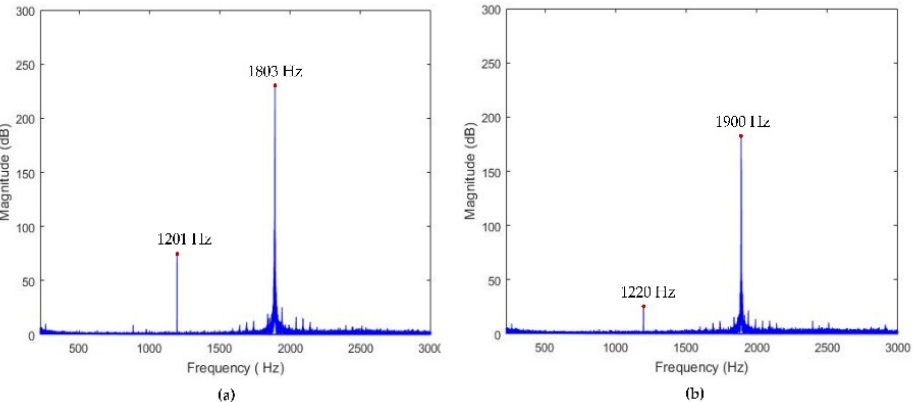
Figure 17. Dynamic responses along ( a ) z-axis and ( b ) x-axis.